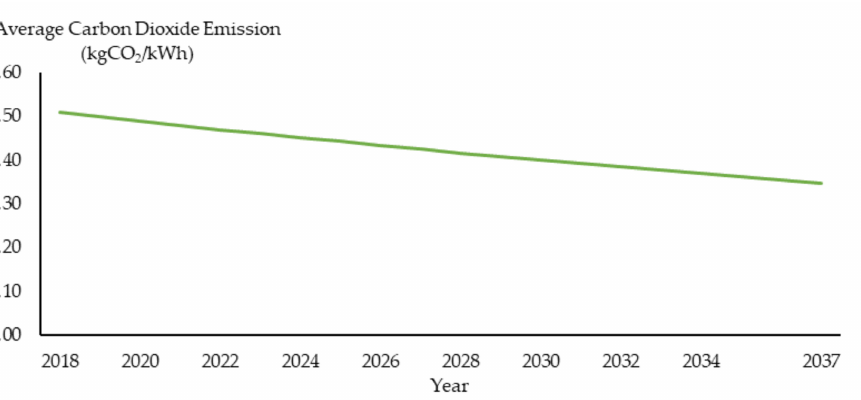
Figure 6. Average carbon dioxide emission